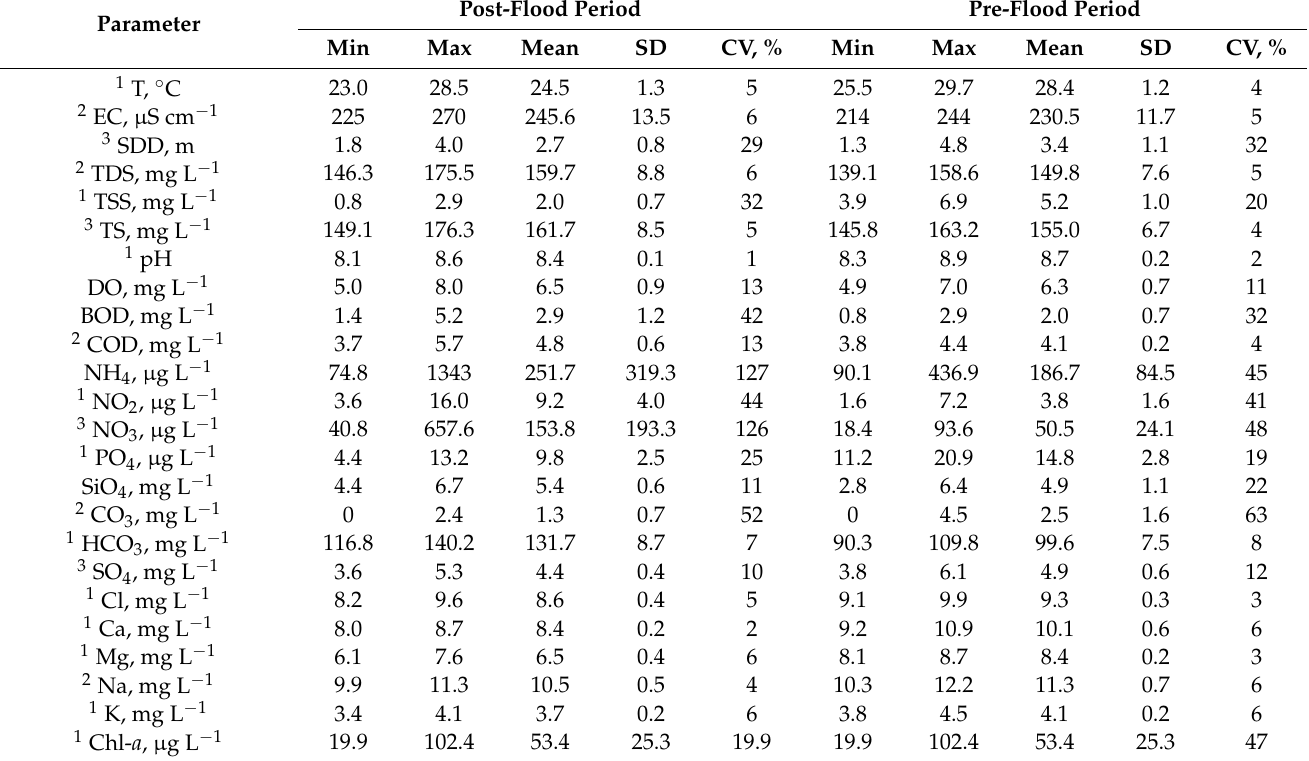
Table 2. Variability of the physicochemical parameters of water in the post-flood and pre-flood periods. Post-Flood Period Pre-Flood Period Parameter Min Max Mean SD CV, %